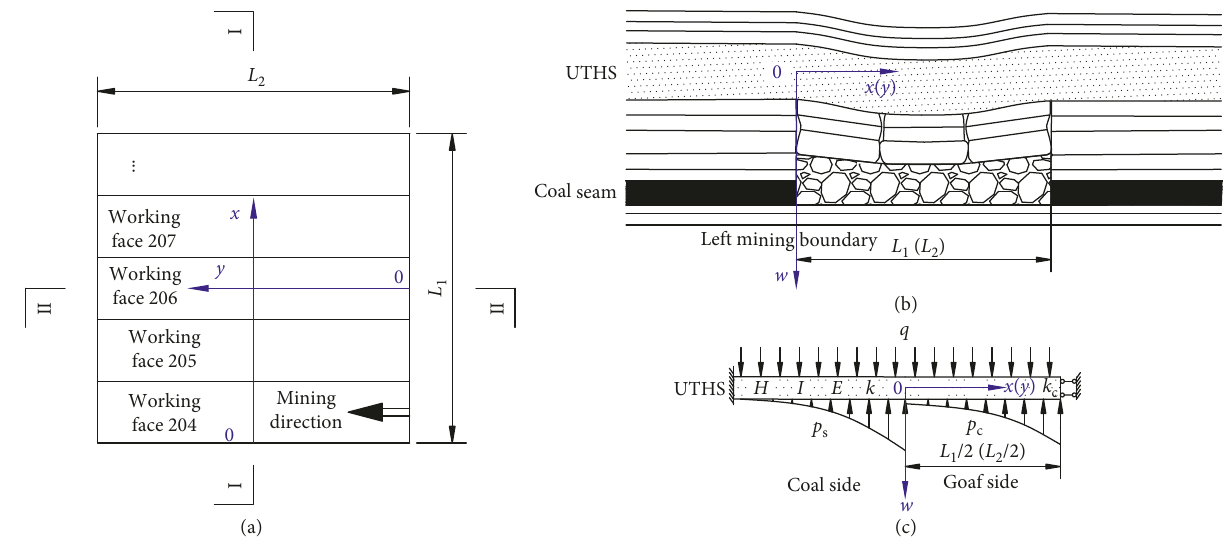
Figure 5: Mechanical model for subsidence prediction for coal mining with UTHS. (a) Simplified floor plan of working faces of second panel in Tingnan Coal Mine. (b) Cross section plot of overburden strata with UTHS in the main section I (II). (c) Subsidence prediction mechanical model for coal mining with presence of UTHS in the main section I